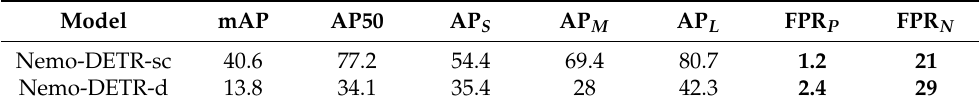
Table 3. Preliminary results (in percentage (%)). False positive rates are marked in bold. FPR P is the false positive rate for the validation set consisting of images containing smoke. FPR N is the false positive rate for the challenging negative test